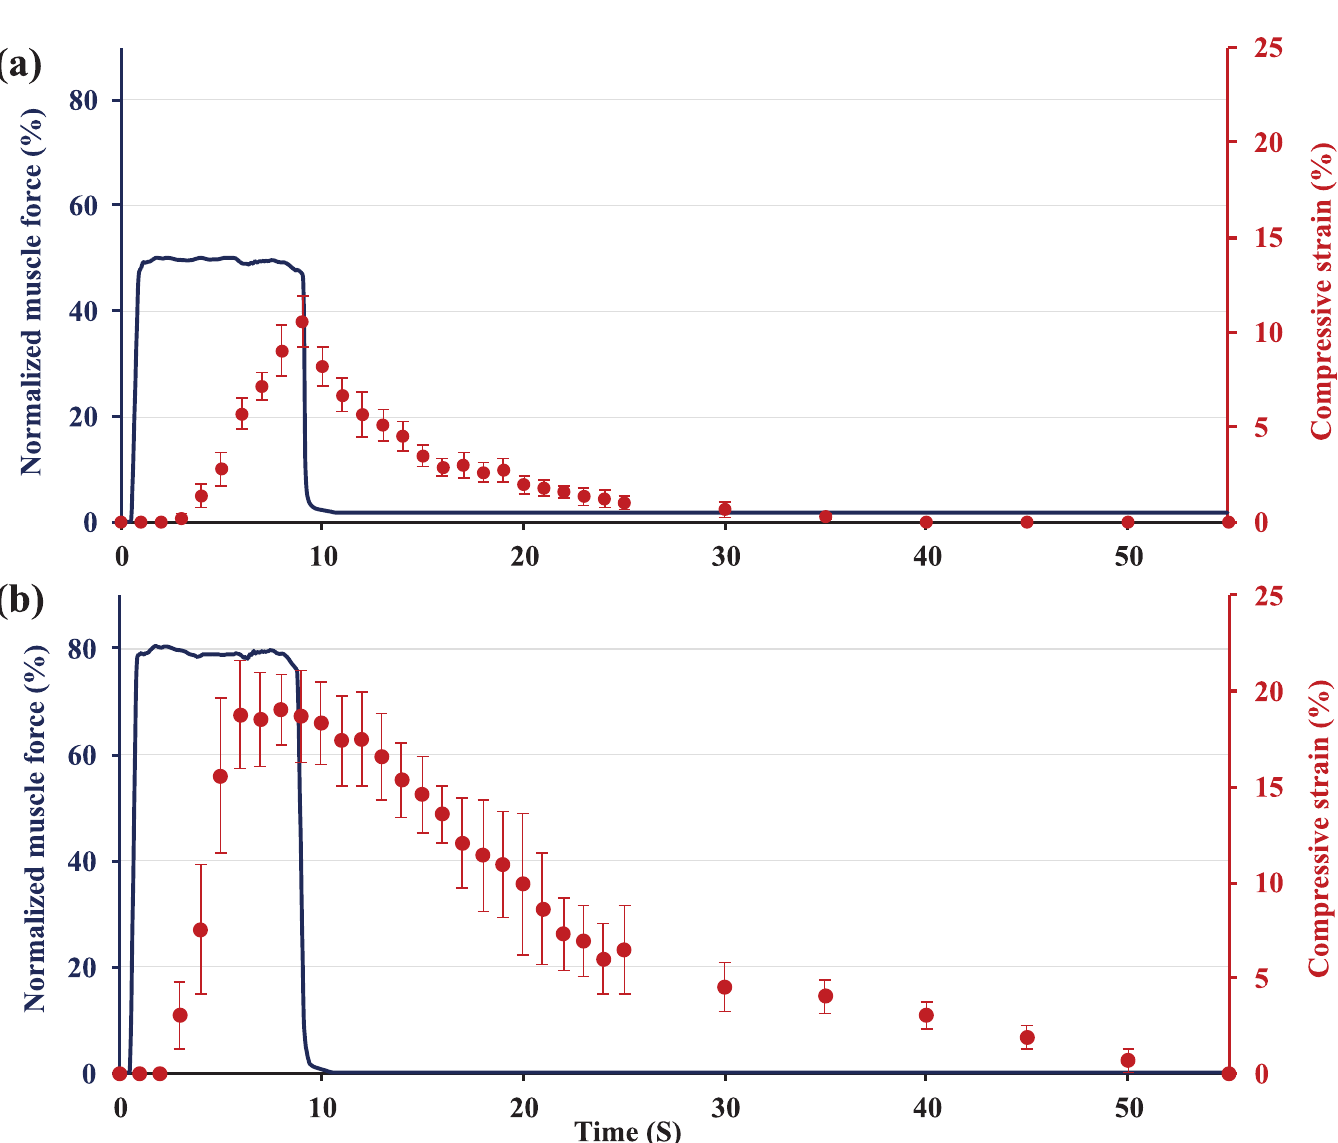
Fig 3. Normalized (relative to maximum = 100%) knee extensor forces as a function of time. Muscles were stimulated for 8s at a voltage and frequency producing approximately (a) 50% of the maximal muscle force, cartilage compressive strain (mean ± 1SD; n = 7) increased almost linearly 3s after the force application. Cartilage takes 20s for full recovery upon unloading. (b) 80% of the maximal isometric force. Cartilage compressive strain (mean ± 1SD; n = 7) increased rapidly and reached near steady state conditions at 6s following force application. Cartilage tissue recovered to its original shape within approximately 45s following force